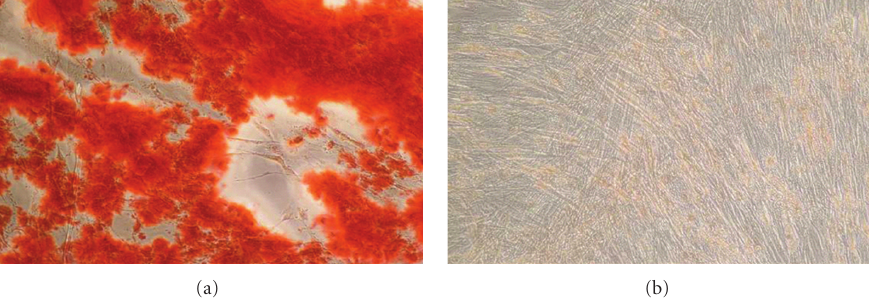
Figure 2: Osteogenic di ff erentiation in vitro. Alizarin Red staining performed 2 weeks after cell transduction, showing a red-colored mineralized matrix in treated cells ((a) AdLMP-3) and negative staining in control cells ((b) Ad Ψ